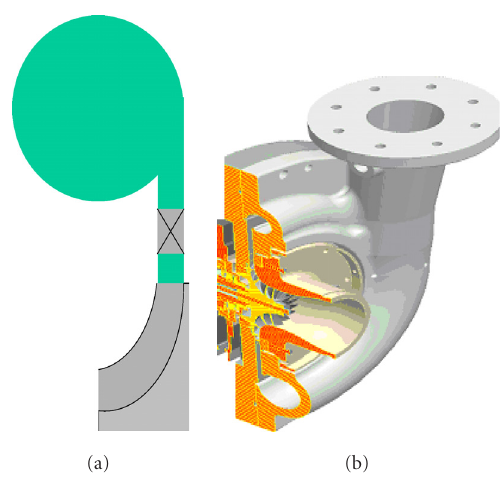
Figure 1: Centrifugal compressor layout. (a) A cross-sectional view, showing the impeller followed by a vaned di ff user, and a volute. (b) An isometric view of the